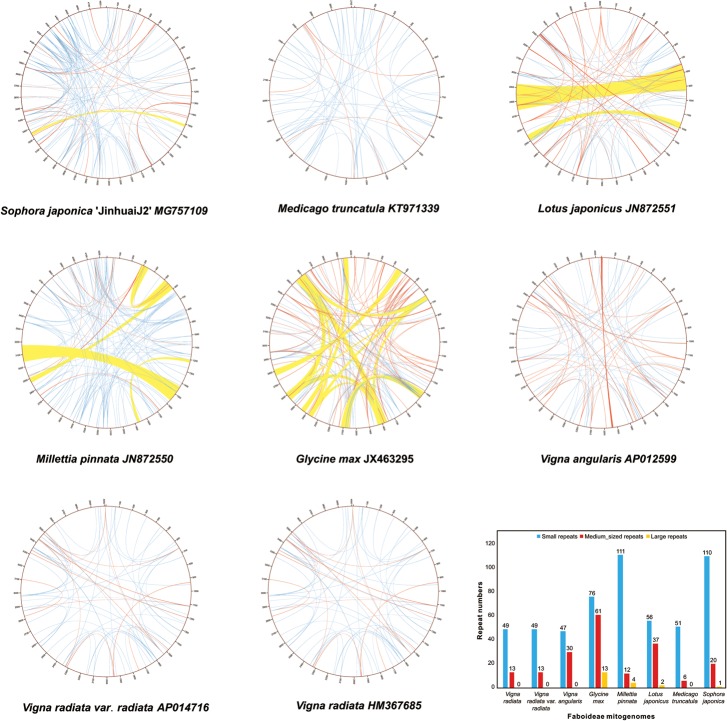
Repeat distributions and occurrences in the eight Faboideae mitogenomes.Large repeats ≥1,000 bp in length are indicated in orange, medium-sized repeats in the range of 100–1,000 bp in length are indicated in red, and small repeats <100 bp in length are colored blue.